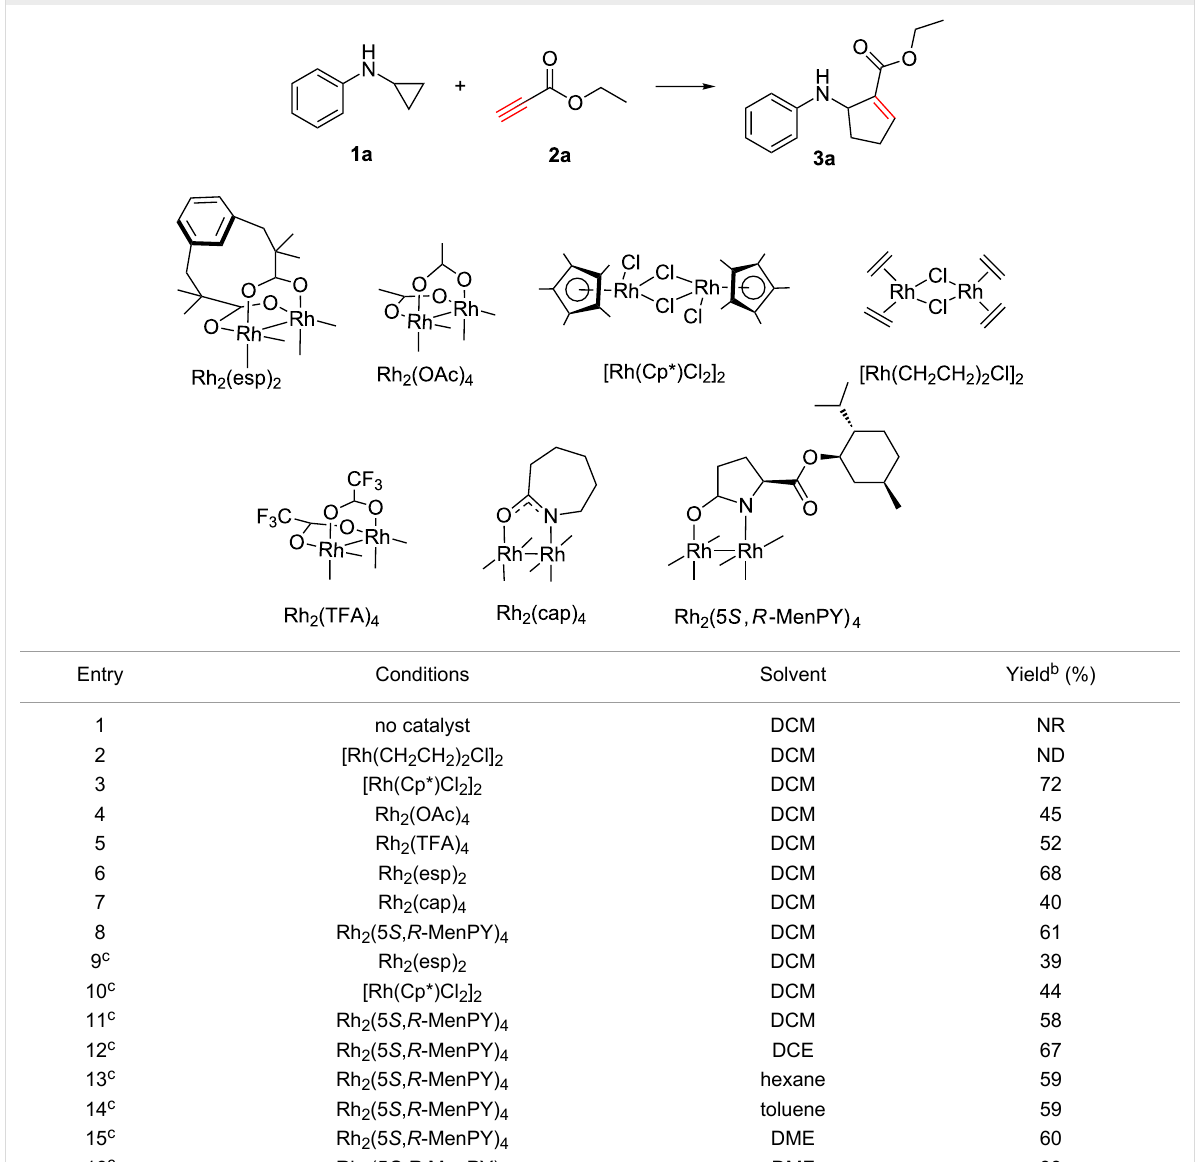
Table 1: Catalyst screening and optimization of reaction conditions a